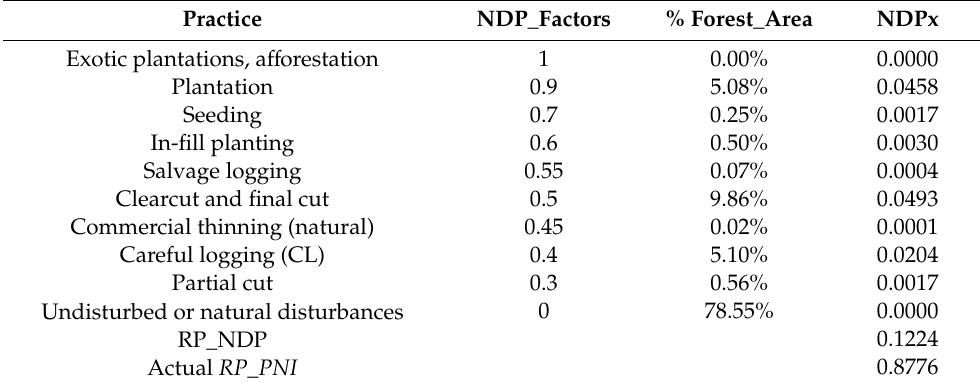
Table 6. Naturalness degradation potential (NDP) for regeneration process (RP) by silvicultural treatments in Quebec’s boreal